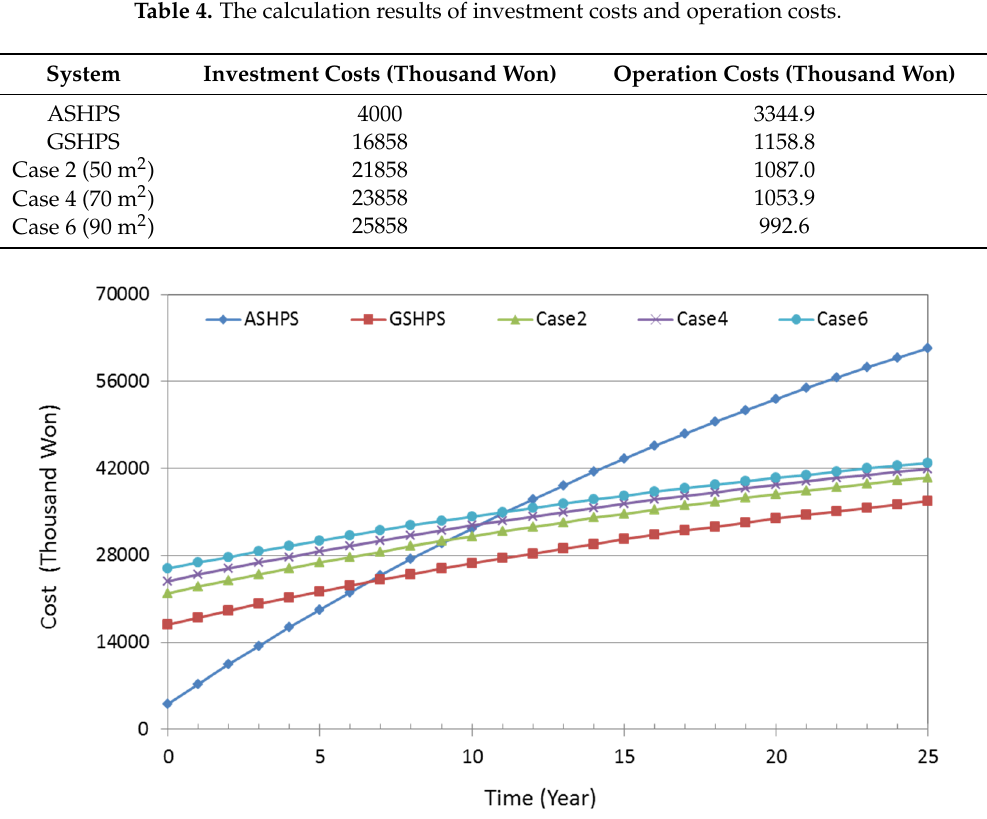
Figure 12. Results of life cycle cost (LCC) assessment.